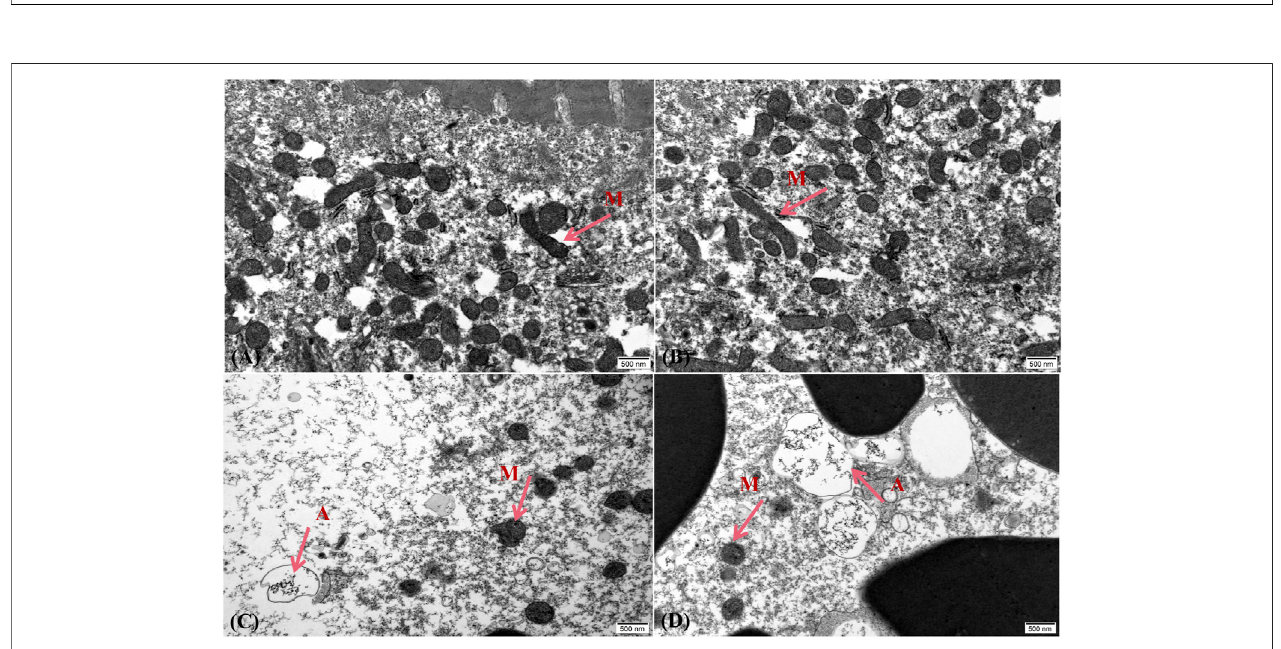
FIGURE 9 | Effect of 4,4 ′ -di-CDE on the ultrastructure of zebra fi sh ovary after 14 days of exposure. The ultrastructure of zebra fi sh ovary exposed to (A) control group, (B) 1 μ g/L, (C) 10 μ g/L, and (D) 50 μ g/L 4,4 ′ -di-CDE, and photomicrographs were taken using ×25000 magni fi cation. M, mitochondria; A, autophagosome.